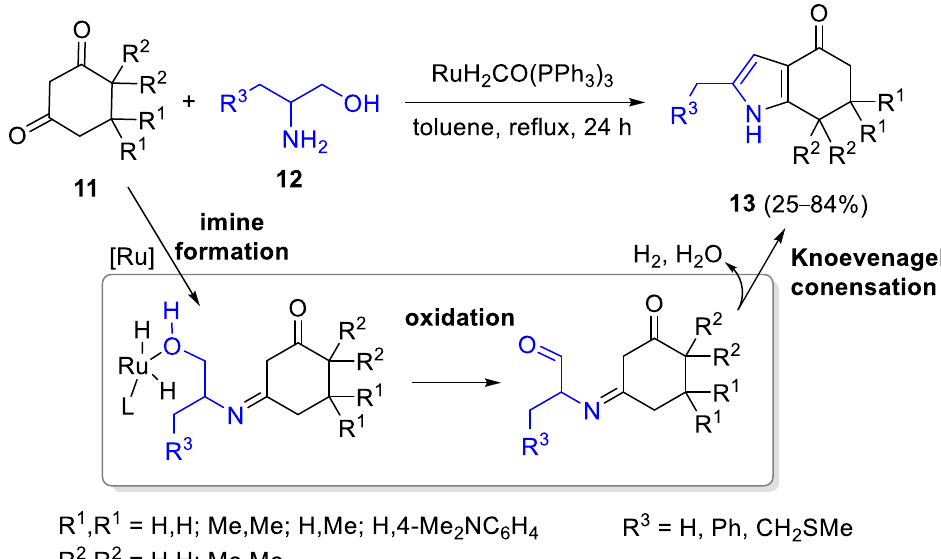
Scheme 5. Synthesis of 6,7-dihydro-1 H -indol-4(5 H